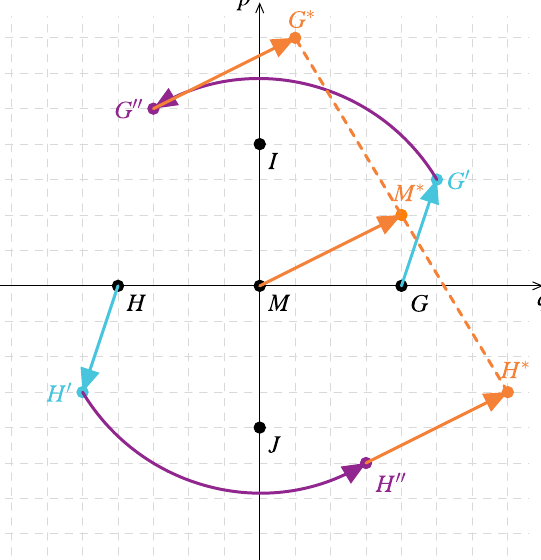
Figure 2. The general Gaussian transformations for input states in opposite directions ( G and H ). The cyan (light) lines show the effect of the squeezing, the purple (dark) lines show the effect of the phase shift, the orange (medium) lines show the effect of the displacement. Note that it is enough to plot the mean of the states, as a Gaussian transformation is a linear transformation in the phase space representation (so the mean of their transformation will be the transformation of their